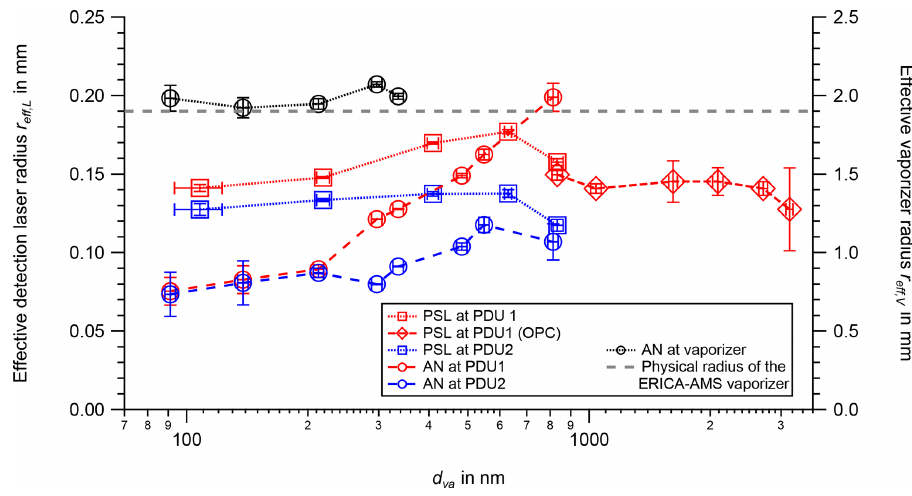
Figure 4. The effective detection laser radius r eff , L as a function of particle size d va determined for PDU1 (red, left ordinate) and PDU2 (blue, left ordinate) with PSL (squares) and AN (circles) particles and the effective vaporizer radius r eff , V as a function of particle size d va for the ERICA-AMS vaporizer (right ordinate, black) determined with AN particles. CPC and OPC measurements are as for Fig. 3. The physical vaporizer radius is marked by a dashed gray line. The uncertainties in the effective radii result from the curve fittings (1 standard deviation). The uncertainty in r eff , L for the PSL measurement with particle size of 108nm was estimated to be 0.002mm (PDU1) and 0.004mm (PDU2), and the uncertainties in r eff , L for the AN measurements with particle sizes of 138 and 91nm are conservatively estimated to be 0.009mm at PDU1 and 0.014mm at PDU2. These values are the approximated maximum uncertainties in r eff , L in the considered size range of 213 to 814nm at PDU1 and PDU2. For the measurement with AN particles of 91nm in diameter, the uncertainty in r eff , V was estimated to be 0.08mm.